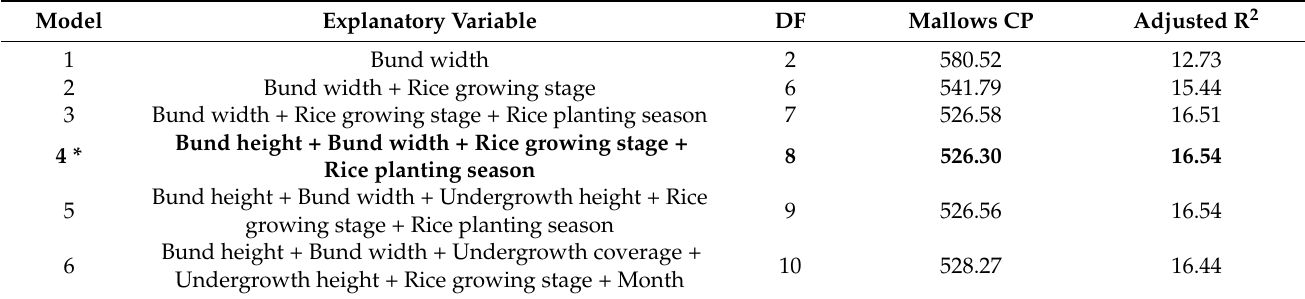
Table 4. Best subsets from candidate models. The most parsimonious model (labeled with * and bolded) has six explanatory stand-level variables with the lowest Mallow Cp and highest adjusted R 2 influence to relative rodent abundance.